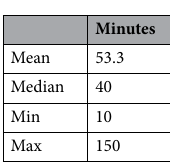
Table 3. Patient usage of virtual reality.